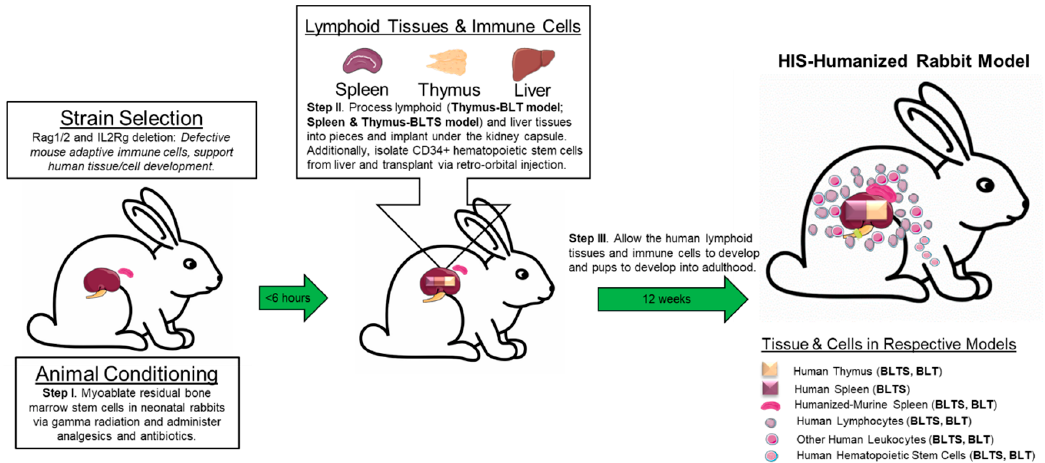
Figure 1. Illustration of the construction of the human immune system (HIS)-humanized rabbit models. First, immunodeficient rabbits, for example the ones with defects in recombination activating gene 1/2 (Rag1/2) and interleukin 2 receptor subunit gamma (IL2Rg), are developed and myoablated via gamma irradiation or busulfan, followed by the administration of antibiotics and analgesics at 1 to 2 weeks after birth. Cold-induced anesthesia is induced prior to surgery. Second, to generate human lymphoid tissue xenografts along with autologous immune cell reconstitution in the rabbits, human fetal lymphoid tissue(s) and liver are processed into 1 mm 3 pieces, and autologous CD34 + hematopoietic stem cells (HSCs) are isolated from the fetal liver via immunomagnetic selection of CD34 + cells. CD34 + HSCs are then transplanted into the neonatal rabbit via intrahepatic injection following renal capsule transplantation of the lymphoid tissues. Third, the transplanted rabbit is maintained under specific pathogen-free conditions and the lymphoid tissue(s), and/or immune cell reconstitution in the peripheral blood, are allowed to develop over a period of 3 months, resulting in the HIS-humanized rabbit model. BLTS: bone marrow stem cells, liver, thymus, and spleen. BLT: bone marrow stem cells, liver, and thymus.